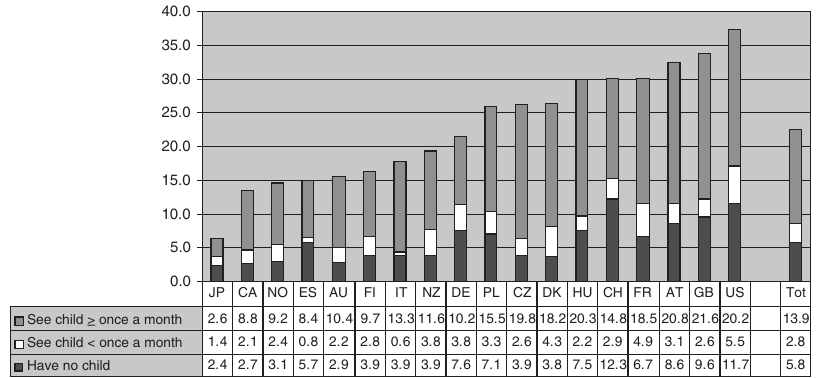
Figure 2. Bar chart showing proportion li v ing alone, by contact with adult